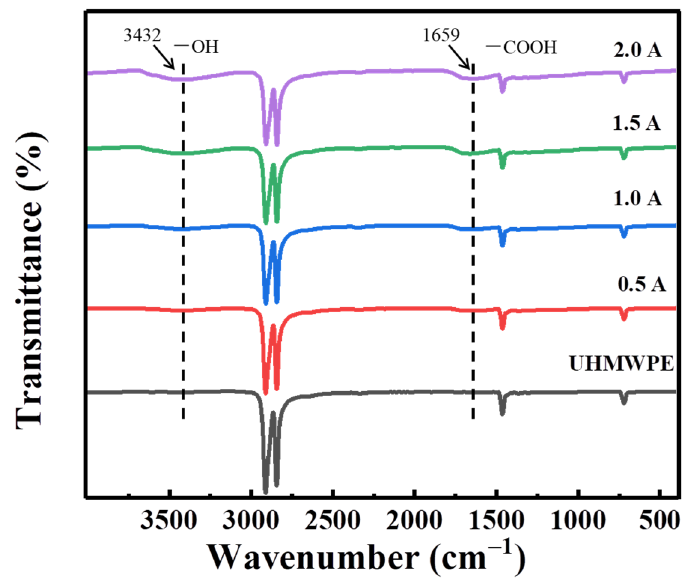
Figure 1. FTIR of UHMWPE substrates treated with different carbon plasma currents.